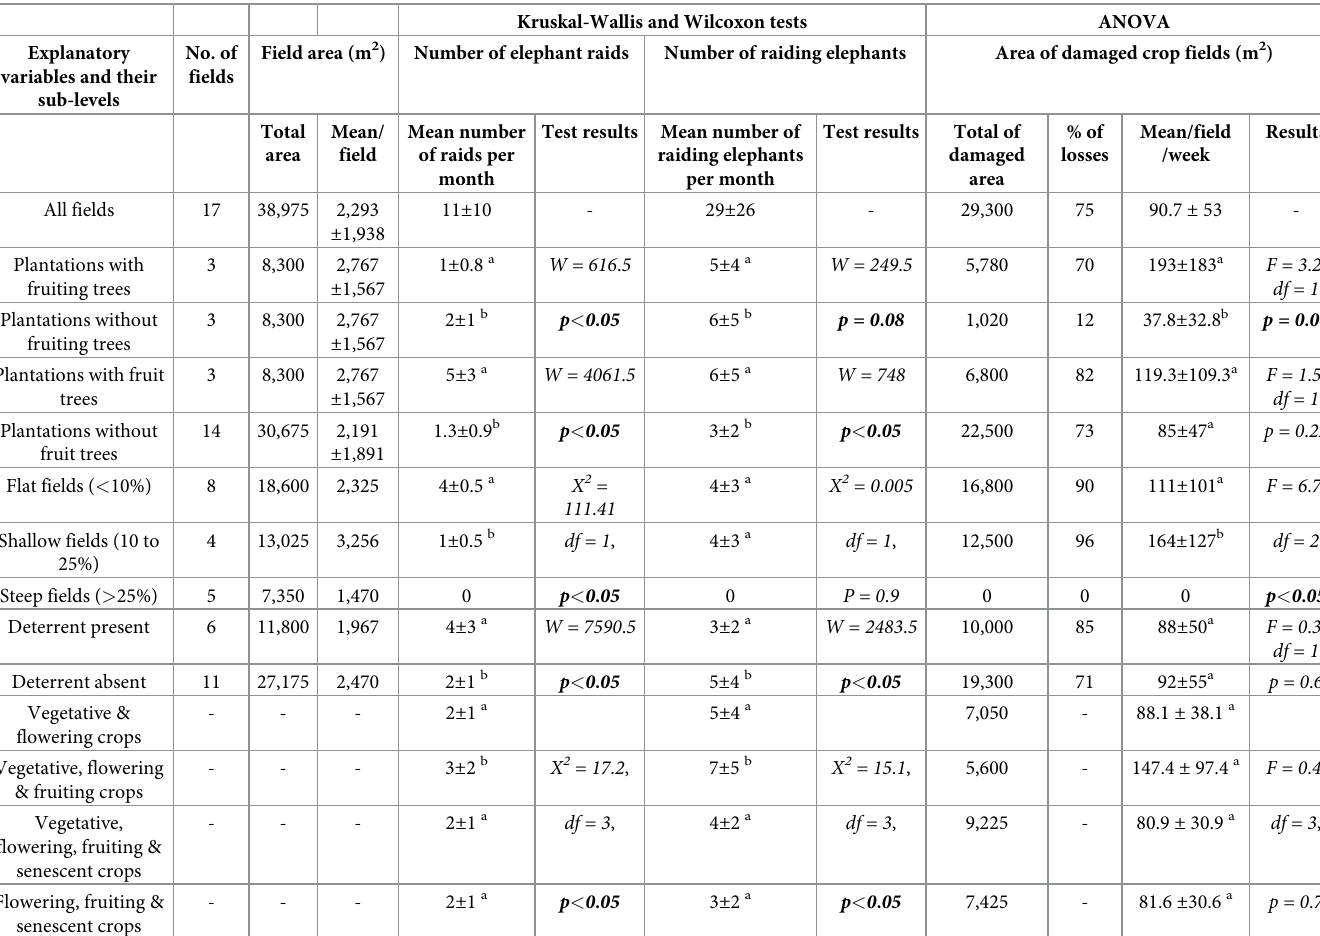
Table 2. Results from the survey of 17 plantations in two focal